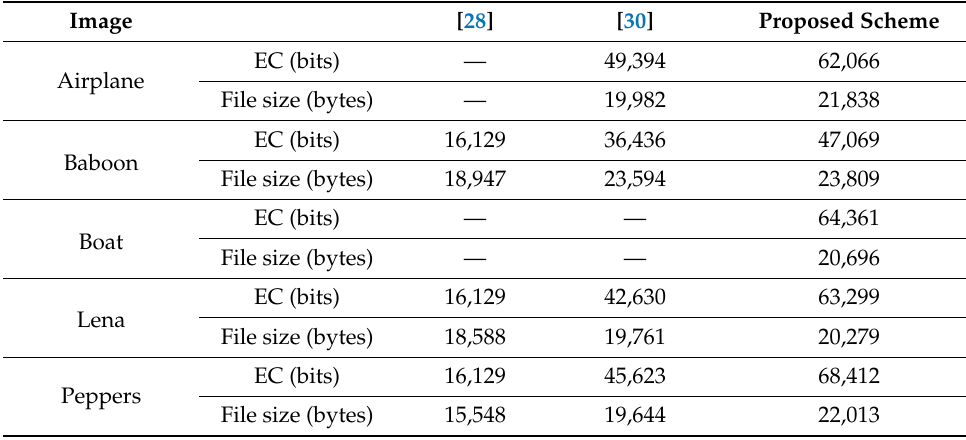
Table 5. Comparisons of EC and file size with de-clustering schemes.